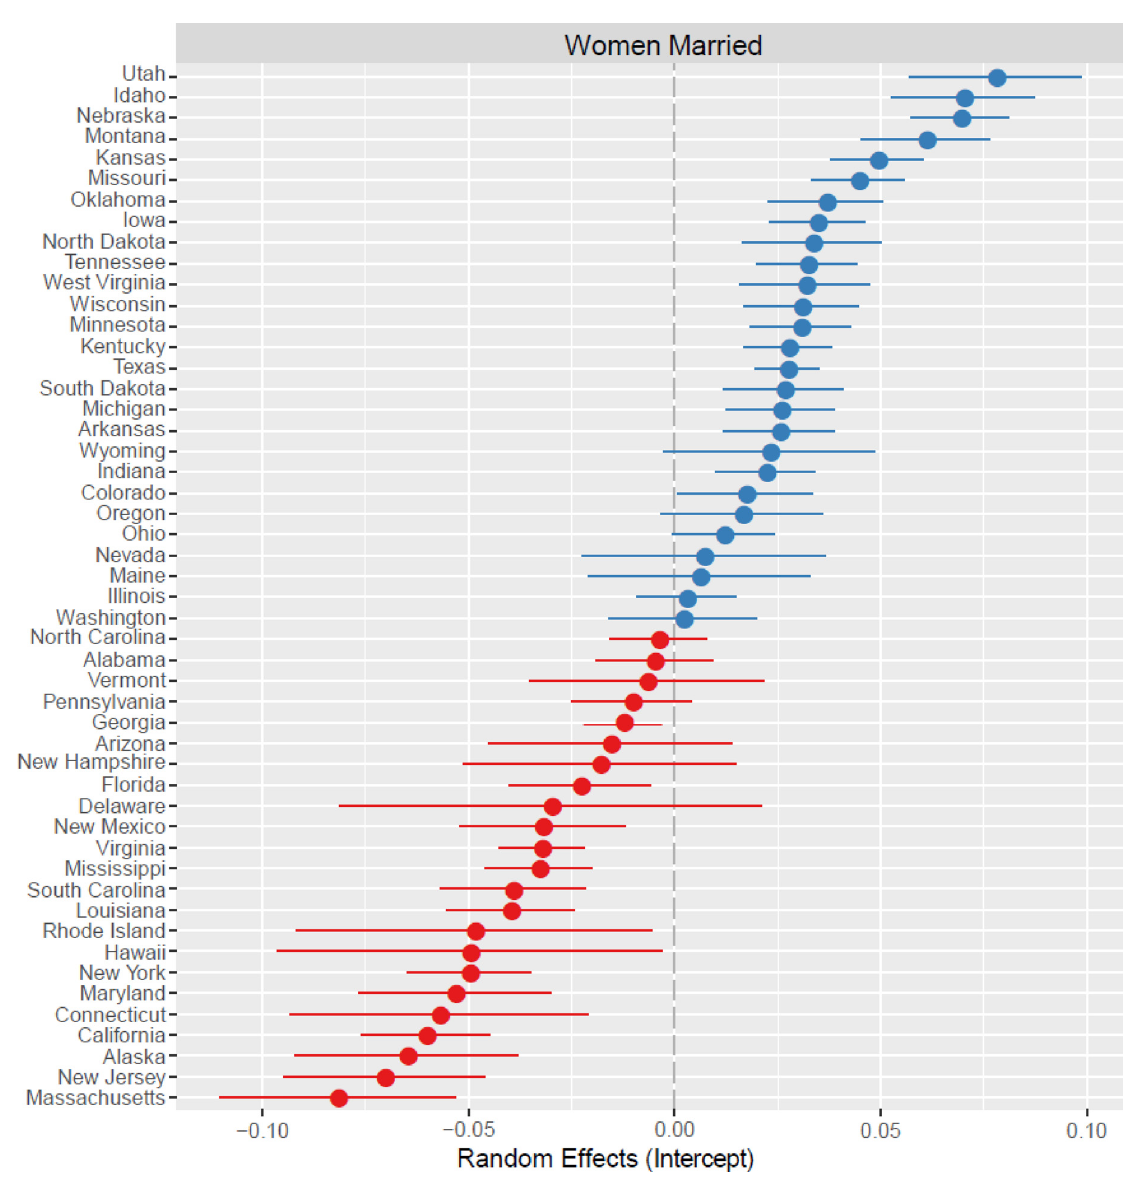
Fig 1. Plot of the random effects for the outcome variable Women Married. State-level deviations are shown relative to the mean (0.00; gray dashed line) with 95% confidence intervals around the intercept (closed circle). Blue circles represent intercepts higher than the mean and red circles lower than the